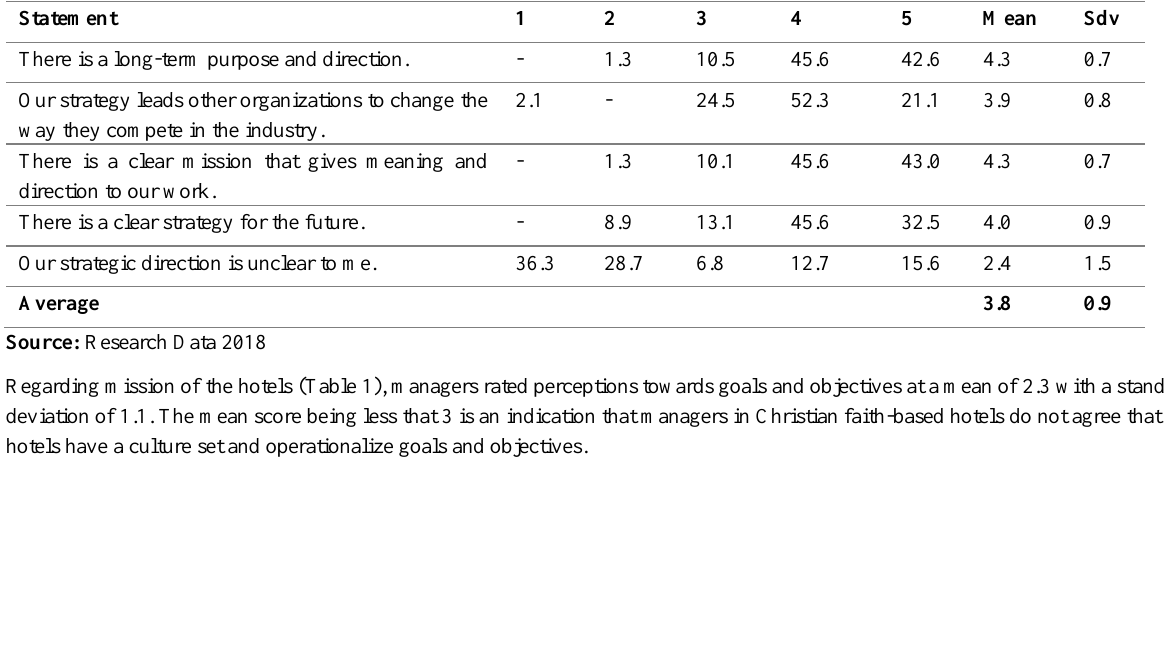
Table 2: Subordinate staff’ Perception on Strategic Direction & Intent of their